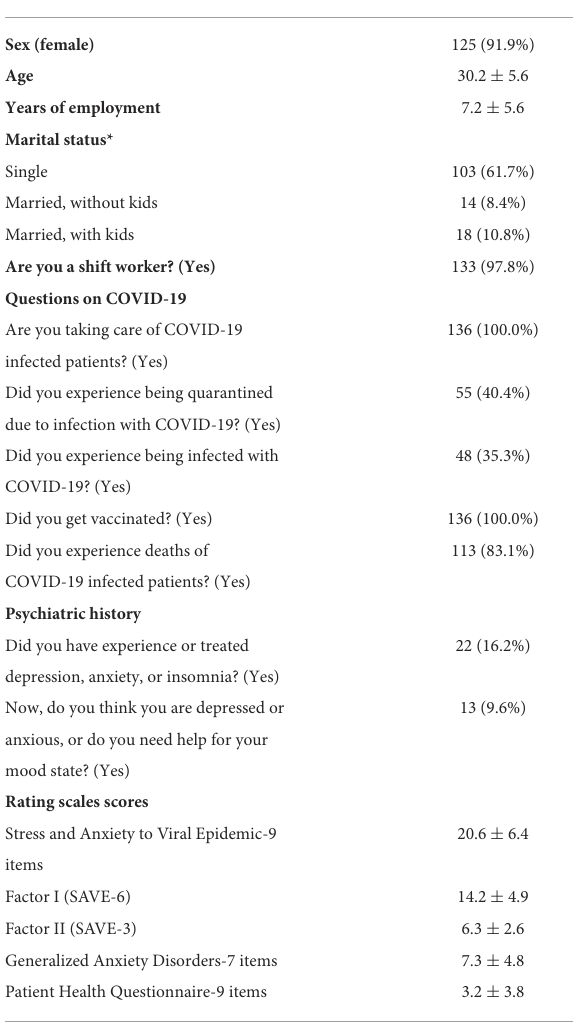
TABLE 1 Clinical characteristics of participants ( N =